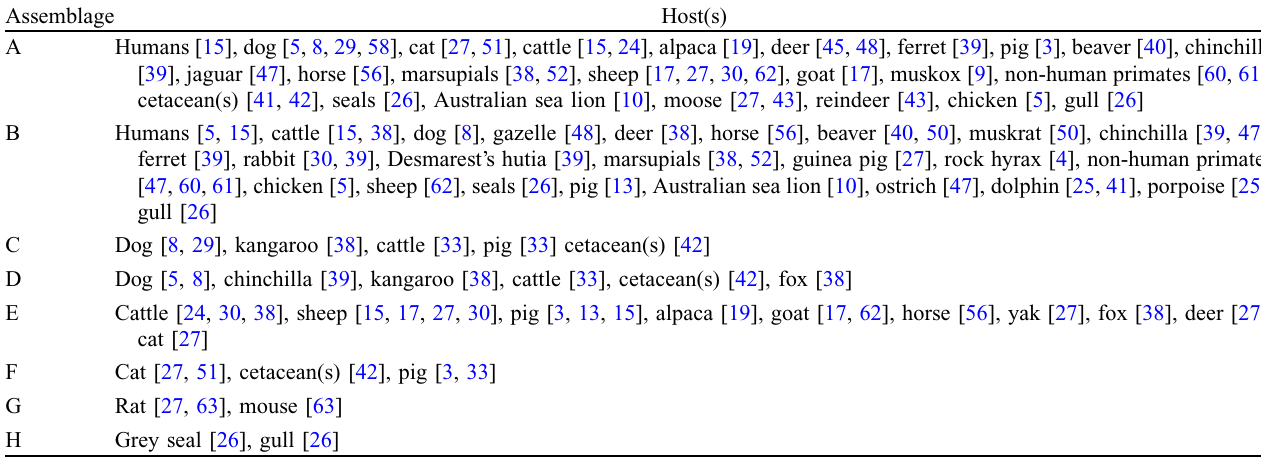
Table 1. Giardia duodenalis assemblages and corresponding hosts.